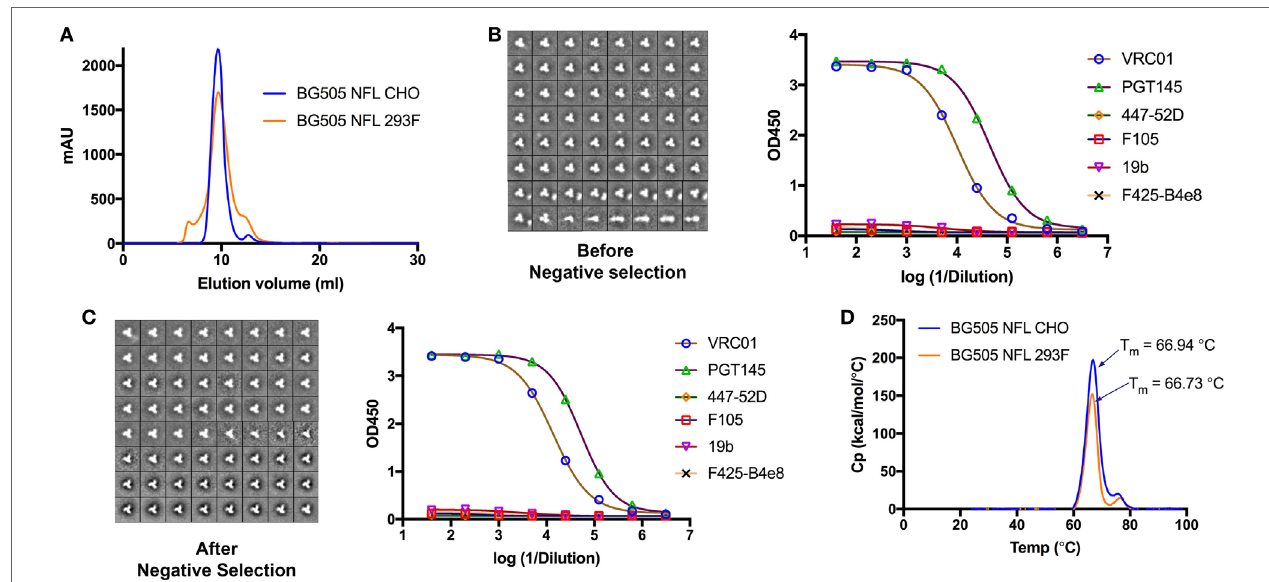
FigUre 2 | Characterization of CHO-M cell-produced BG505 NFL trimers. (a) We superimposed size-exclusion chromatography (SEC) profiles of BG505 NFL produced from CHO-M and 293F cells, respectively, following purification from a lectin-affinity column. The trimers produced from CHO-M cells were more homogenous while the oligomers expressed from the 293F cells displayed predominant trimer and detectable levels of aggregate, dimer, and monomer fractions. (B) Negative stain electron microscopy (nsEM) and ELISA binding analysis of BG505 NFL trimers produced in CHO-M cells from the peak fraction following lectin-affinity and SEC isolation. (c) nsEM and ELISA analysis of BG505 NFL trimers following F105-based negative selection. (D) Melting profiles of BG505 NFL trimers produced in CHO-M and 293F cells as measured by differential scanning